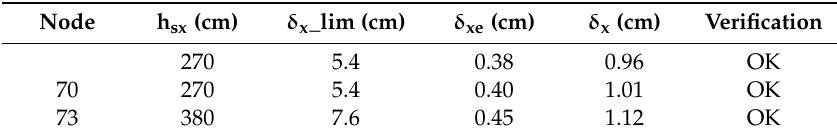
Table 14. Displacements verification for PGA = 0.5 g soil class A (more aggressive than scenario PGA = 0.2 g soil class D). Adapted from